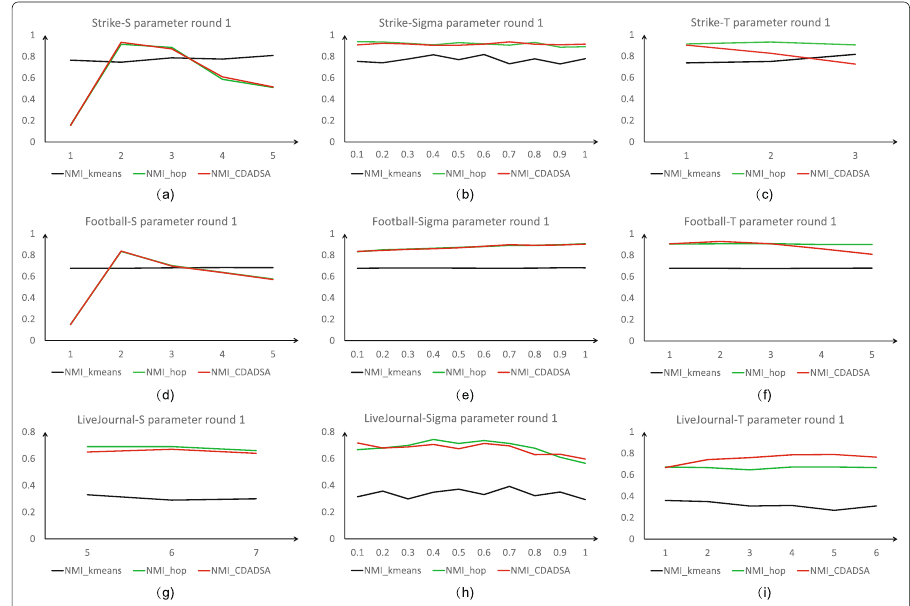
Fig. 7 The first-round experimental results of the parameter